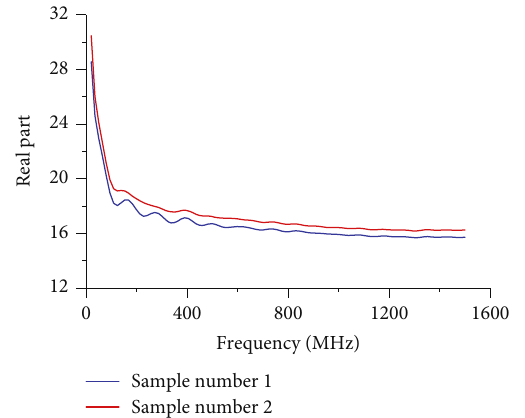
Figure 9: The real part of dielectric permittivity of samples changing with the same water content and compaction level under di ff erent frequency.